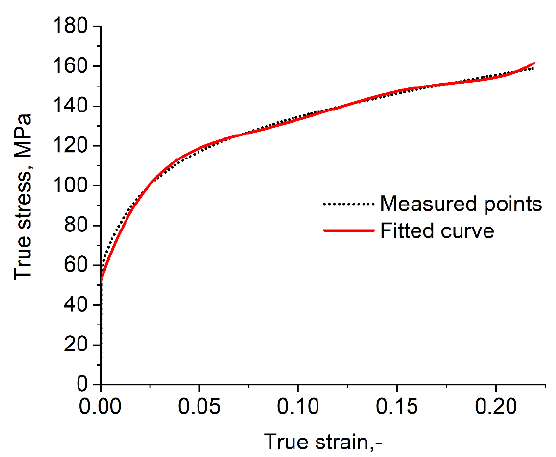
Figure 1. An example for the true stress–true strain measured data and the fitted curve. Direction: 22.5 ◦ .